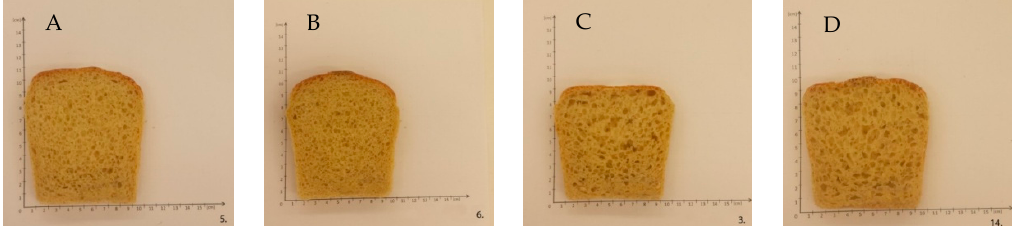
Figure 2. Comparison of crumb porosity in 2016: ( A ) variety Izera, porosity coefficient 70; ( B ) variety Kandela, porosity coefficient 65; ( C ) variety Cytra, porosity coefficient 50; ( D ) variety Zadra, porosity coefficient 45.